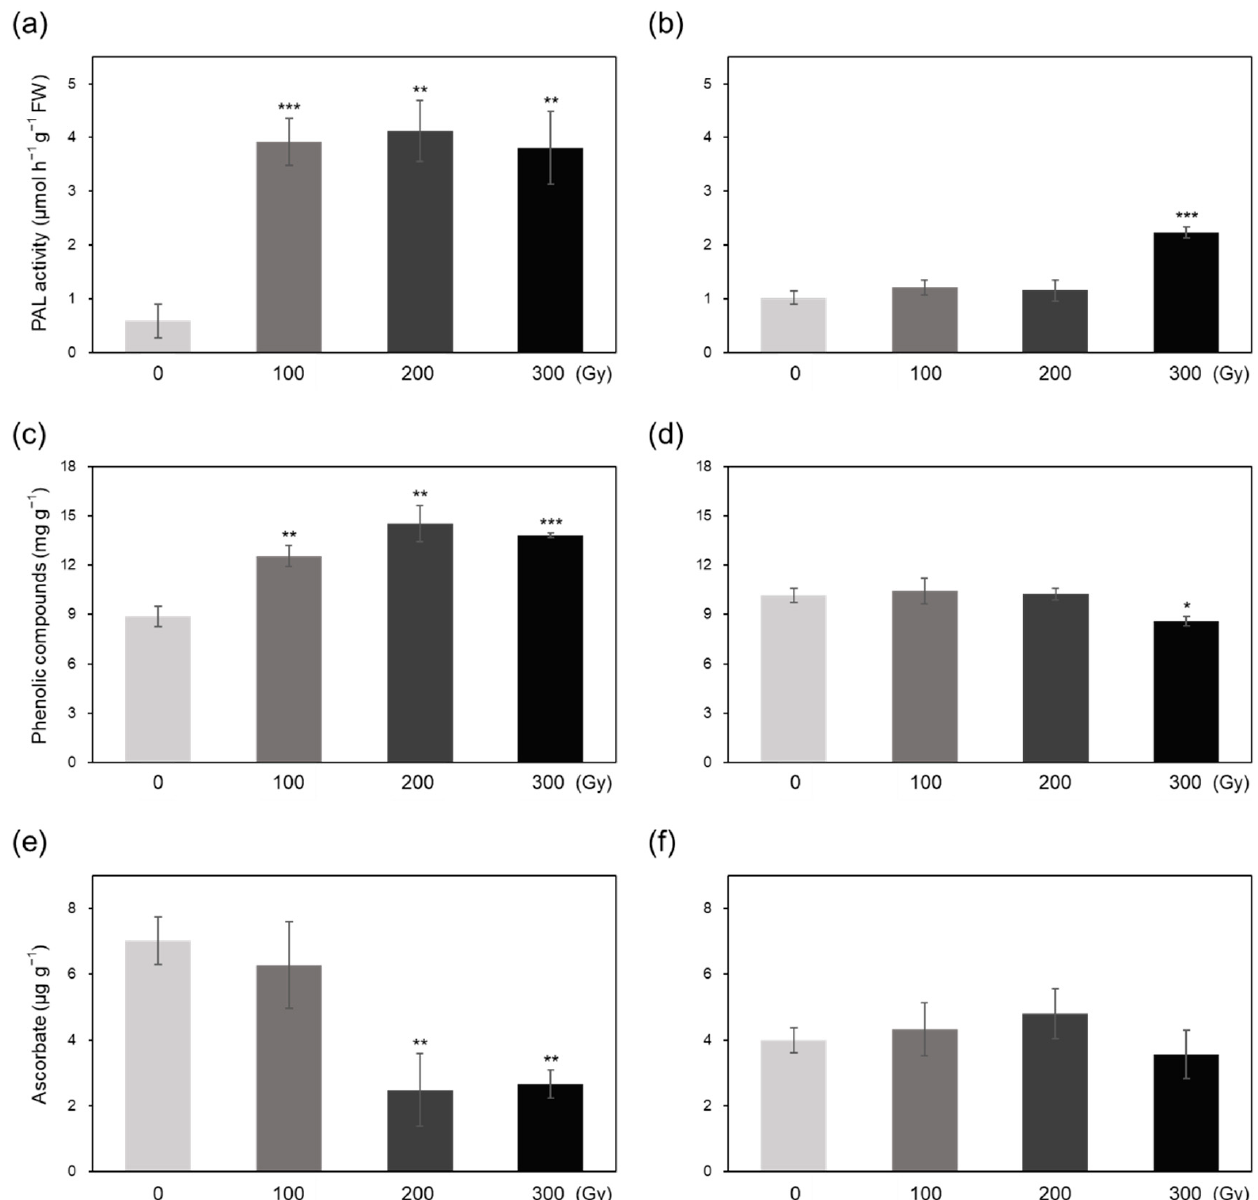
Figure 6. Phenylalanine ammonia-lyase (PAL) activity, phenolic compound content, and ascorbic acid (AsA) content of rice plants subjected to gamma irradiation. ( a – f ) PAL activity ( a , b ), phenolic compound content ( c , d ), and AsA content ( e , f ) of rice plants subjected to acute ( a , c , e ) and chronic ( b , d , f ) gamma irradiation. Data represent mean ± SD. Asterisks indicate significant differences between control (0 Gy) and other treatments (* p < 0.05, ** p < 0.01, *** p < 0.001).